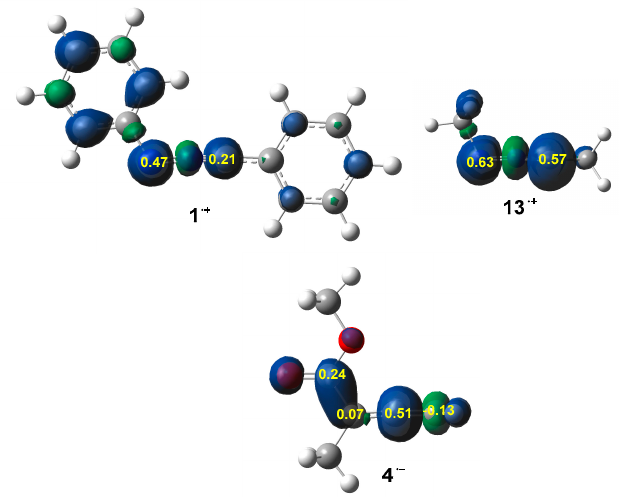
Figure 2. 3D representations of the Mulliken atomic spin density of the radical cations 1 · + and 13 · + , and the radical anion 4 · − , together with the nucleophilic P − electrophilic P + Parr functions of allenoate 4 k